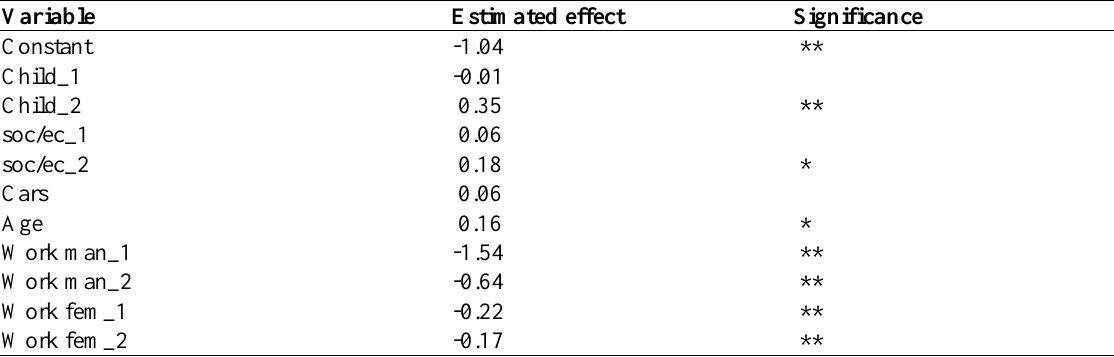
Table 2. Effects of the independent variables on probability of spending time together or